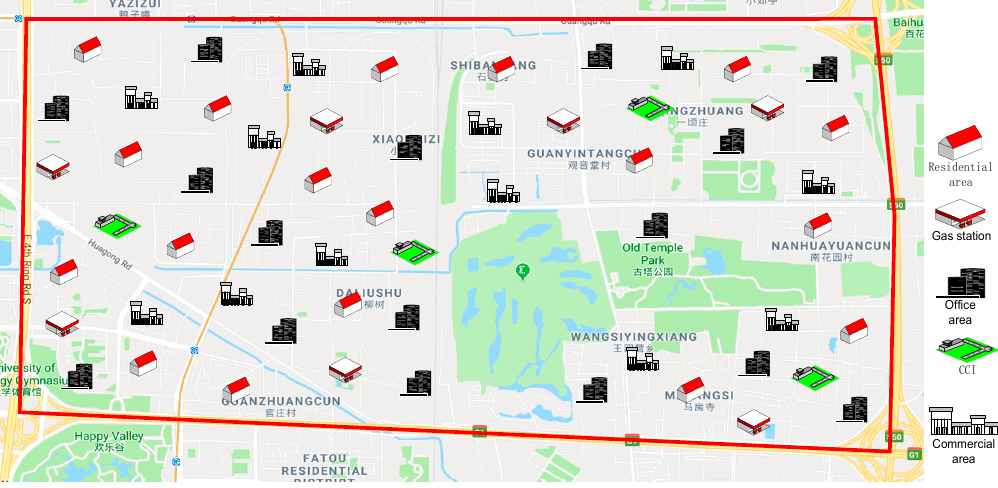
Figure 6. The geographical locations of typical load regions, gas stations and CCIs.